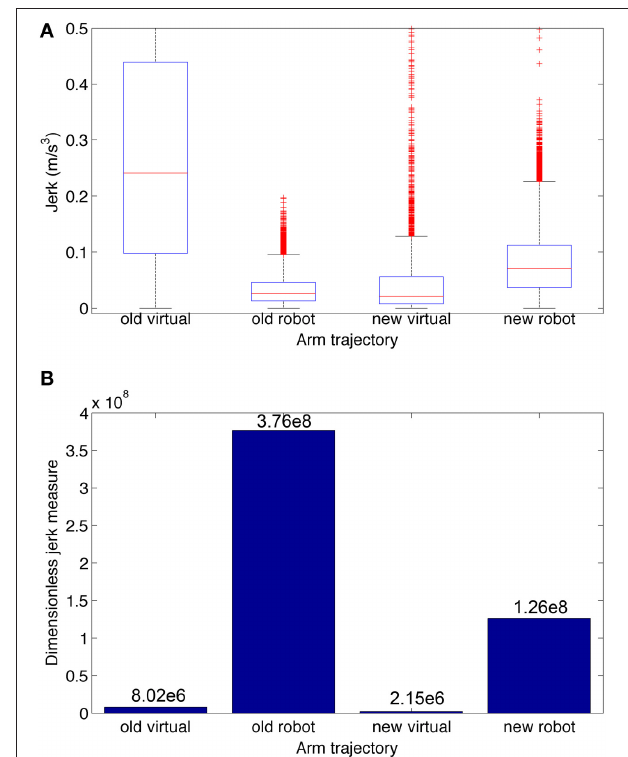
FIGURE 10 | Jerk-based comparison of smoothness for the four trajectories depicted in Figure 9: virtual and robot arm trajectories from the previous (“old”) and current (“new”) papers. (A) Boxplot statistics of the jerk (rate of change of acceleration). (B) Dimensionless jerk measure, which quantifies jerk but is independent of trajectory amplitude and duration. The dimensionless jerk measure of the new virtual and robot arm trajectories was lower than those in our previous paper. Number of points/outliers = 227/11 (old virtual), 24997/585 (old robot), 3297/350 (new virtual), and 24997/610 (new